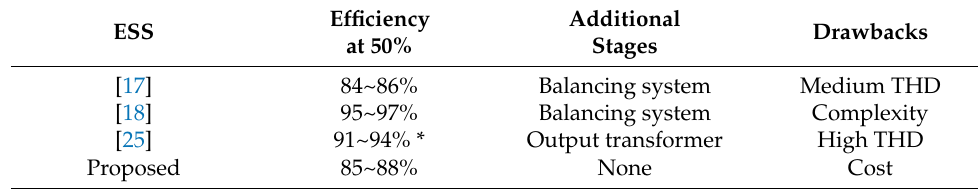
Table 2. Components used for simulations and prototype’s